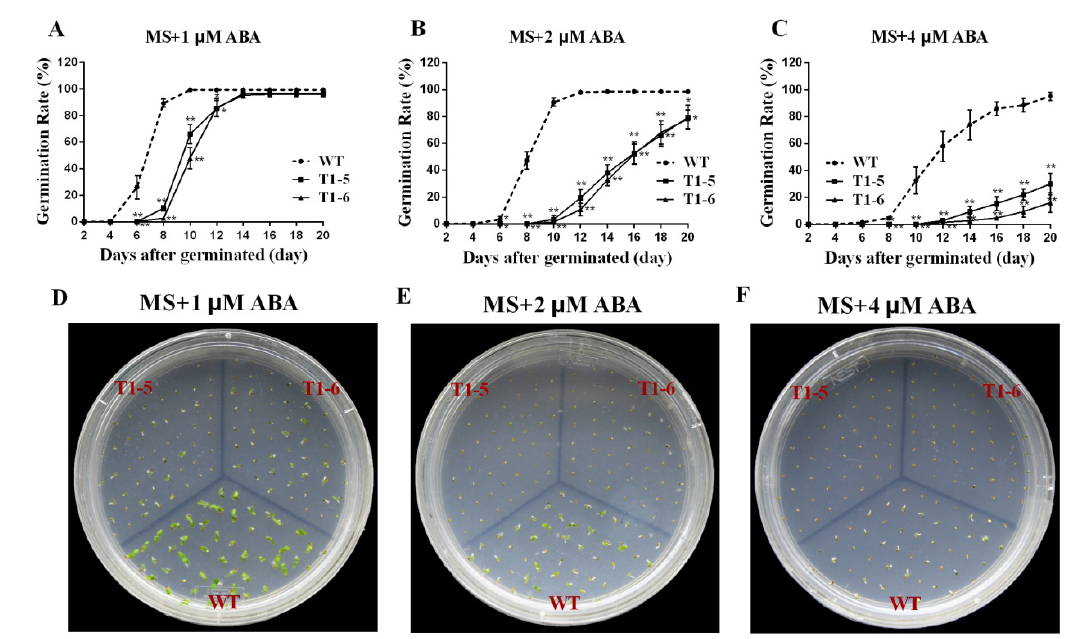
Figure 9. E ff ects of ABA application on germination rates between wild type (WT) and transgenic plants. Per 50 seeds of WT and T1 transgenic plants were sown on sterile MS solid medium supplemented with di ff erent concentrations of ABA ( A – C ). Values are means ± SD ( n = 3). The photographs ( B – D ) were taken after being sown for 9 d. * and ** Significant at p < 0.05 and p < 0.01 compared with WT, respectively.